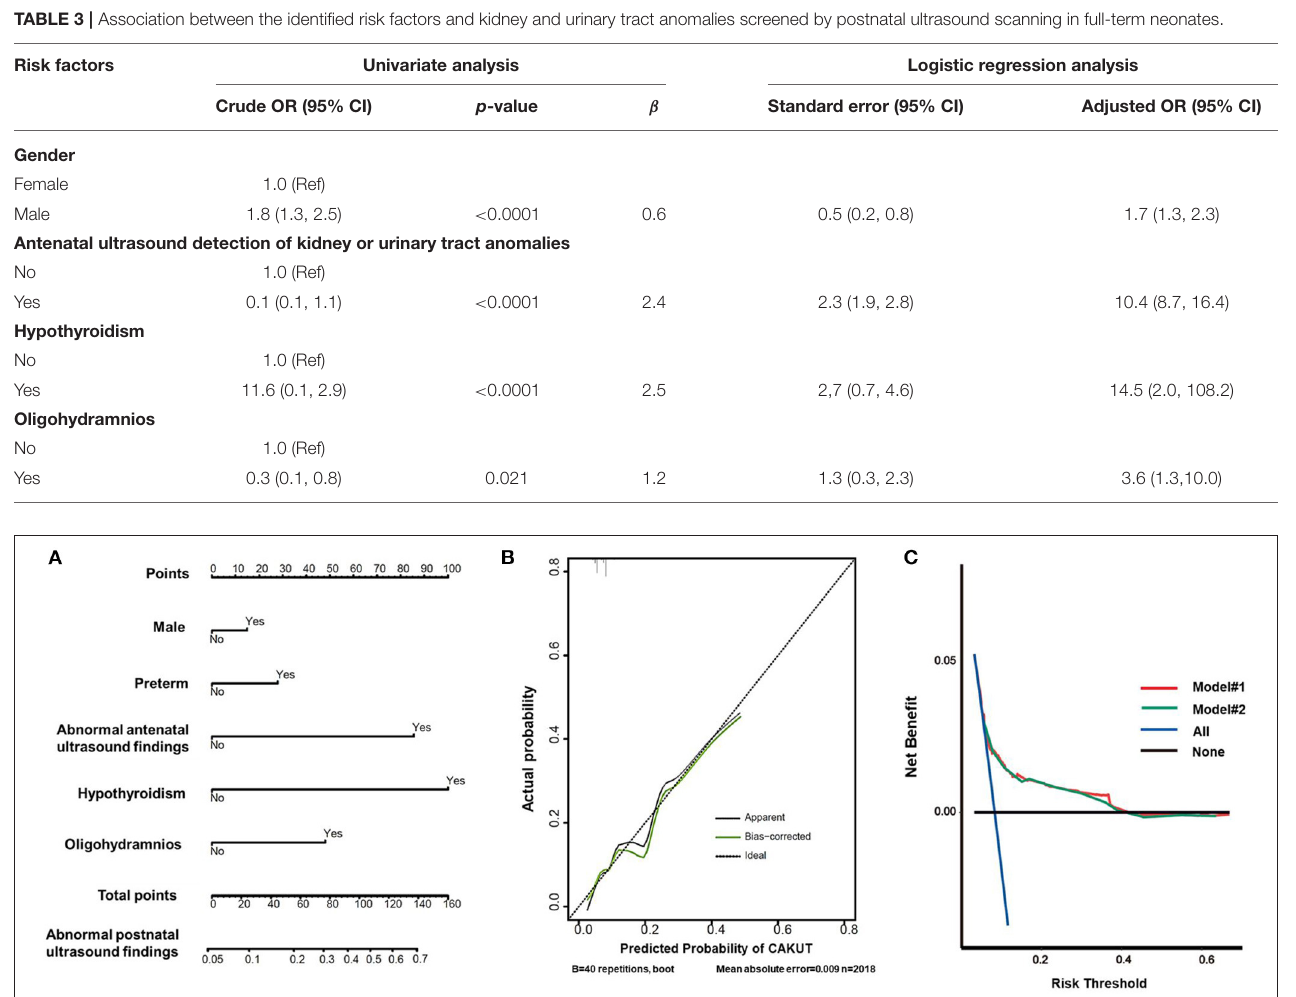
FIGURE 3 | Prediction of abnormal findings by postnatal ultrasound screening for CAKUT. (A) Nomogram predicting postnatal ultrasound screening result. To utilize the nomogram, an individual patient’s value was presented on each variable axis, and the vertical line was down upward to find the number of points received for each variable value. The sum of the variable values was presented on the total point axis and a vertical line was drawn downward to the probabilities of abnormal screening outcome. (B) Calibration curve of the predictive model. The x -axis showed the predicted abnormal screening results. The y -axis showed the actual abnormal screening results. The vertical lines show the frequency distribution of the predicted positive ratio of screening result. The apparent calibration curve (dotted line) indicates the model performance in the original data, while the bias-corrected curve (solid line) represents the model performance after optimism correction using 1,000 bootstrapped resamples. A perfect prediction would fall on the 45-degree (dashed) reference line. (C) Decision curves for the nomogram model. The y -axis measures the net benefit and the x -axis shows the threshold probability. The horizontal black line along the x -axis represents the assumption that no infants will perform postnatal ultrasound screening, whereas the solid aqua line represents the assumption that all infants will perform postnatal ultrasound screening. The red line indicated the nomogram model #1 in participants with the 4 propounding risk factors. The green line indicated the nomogram model #2 in participants with the 12 risk